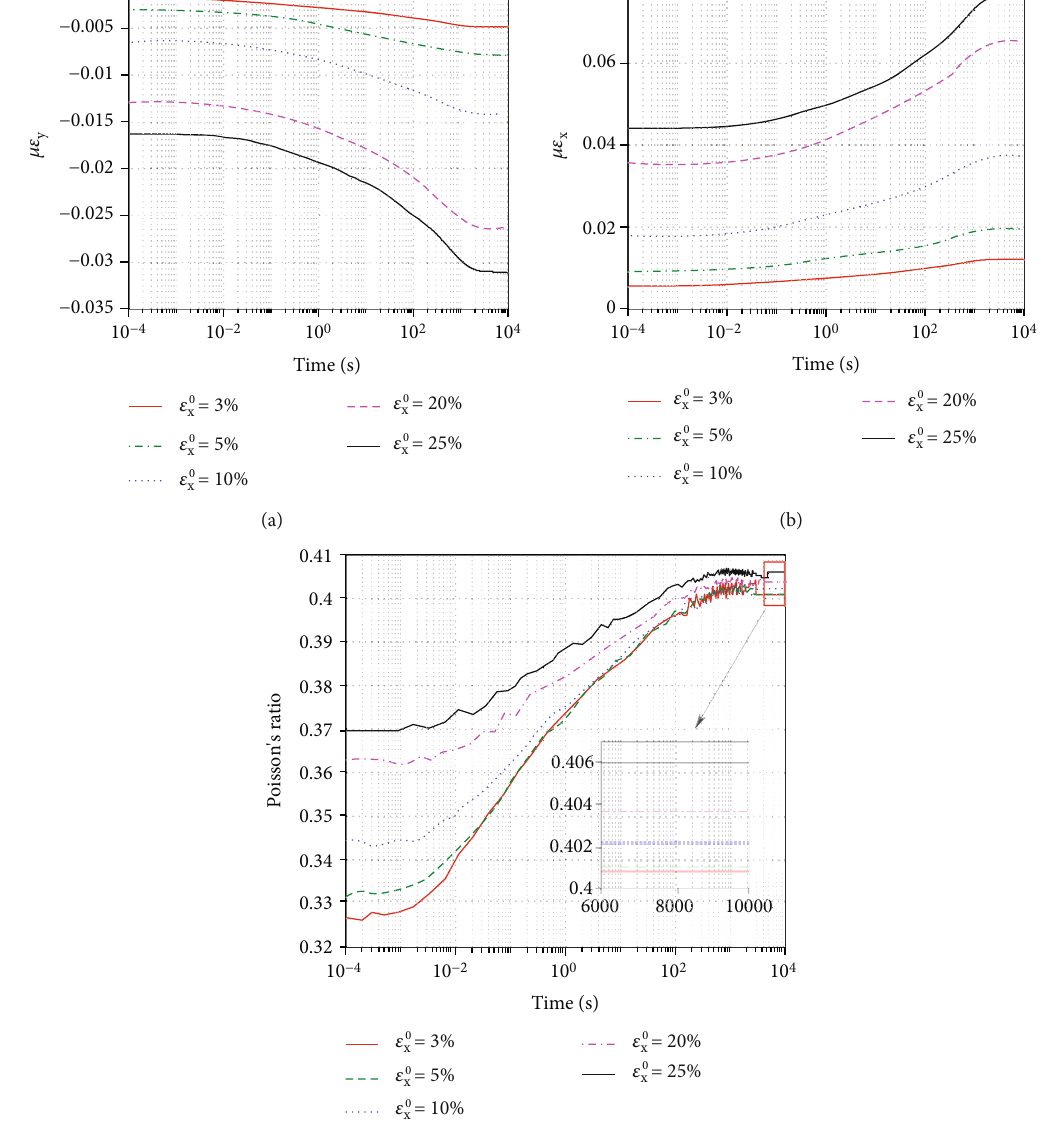
Table 4. For the changed cohesive parameters including cohesive strength, critical displacement, and transition parameter, there is a transition value (or section) that con- trols the tendency of the curve of Poisson ’ s ratio. The two sides of this critical value will result in di ff erent responses.